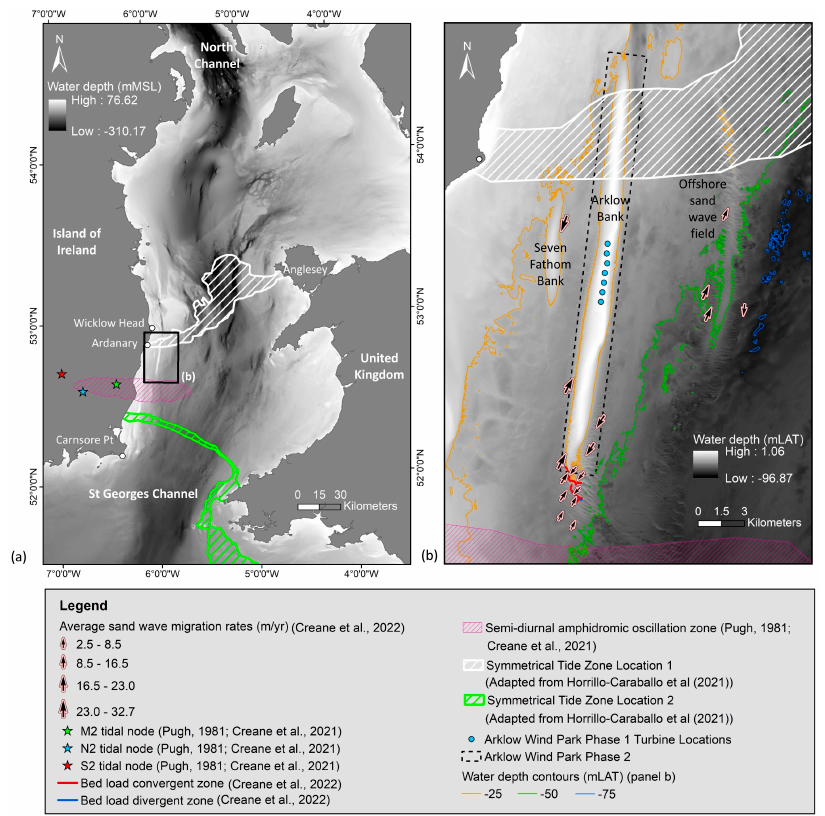
Figure 1. ( a ) Overview of Irish Sea oceanographic phenomena impacting the study site [7,13,23,26]; ( b ) the area of interest, Arklow Bank. Panel ( a ) bathymetry source: EMODnet [27], where MSL is mean sea level; Panel ( b ) bathymetry source: INFOMAR (https://www.infomar.ie/, (accessed on 20 March 2020)), where LAT is lowest astronomical